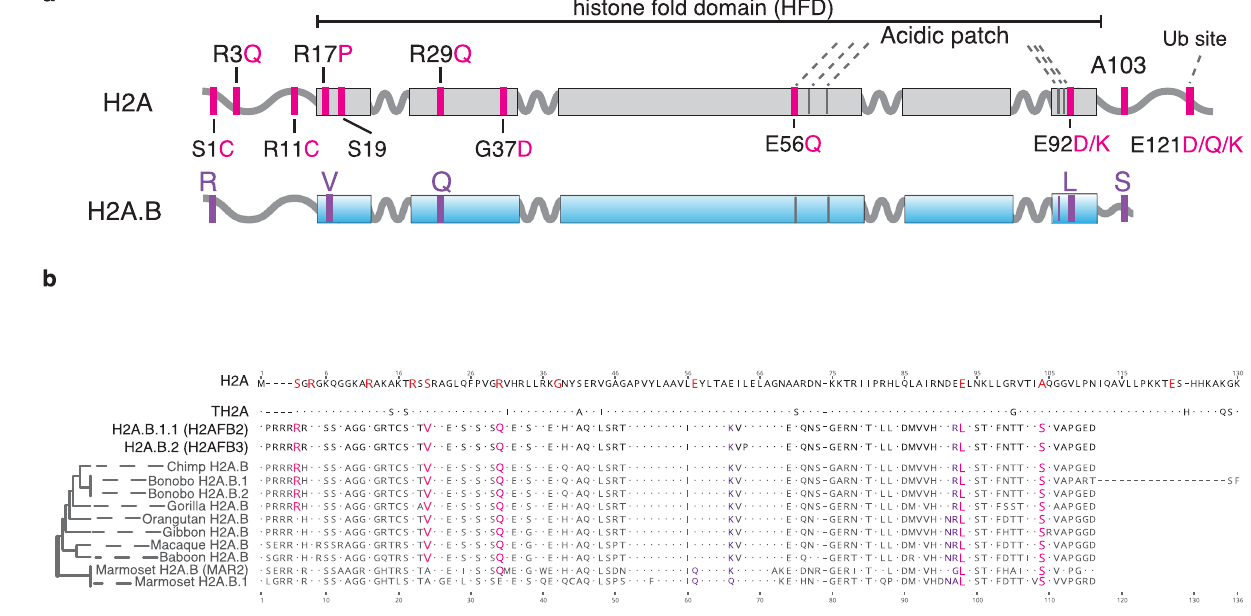
Fig. 1 H2A.B possesses oncohistone features that are conserved throughout primates. a Schematic of common oncomutations found in human core H2A and their status in H2A.B. Marked sites on core H2A show WT amino acid position followed by its most common cancer-speci fi c substitution in TCGA (pink). Associated sites found in WT short H2As are shown in purple. b Protein alignment of core H2A, testis-speci fi c H2A (TH2A), and H2A.B paralogs from Human and representative primates. Substitutions corresponding to oncohistone mutations in H2A (see Fig. 1.) are shown in